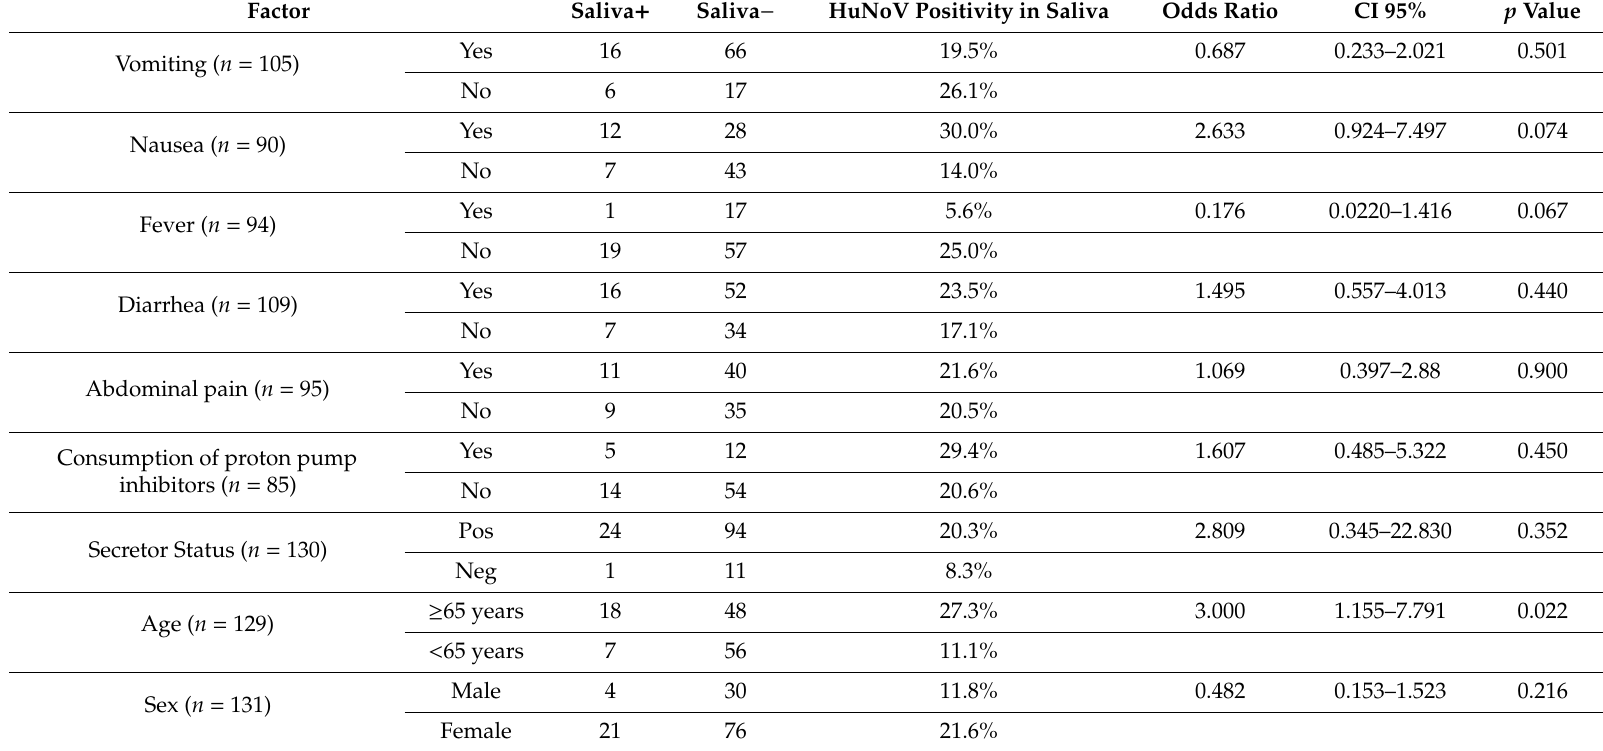
Table 4. Risk factors for occurrence of HuNoV in saliva in GII studied cases (* p <